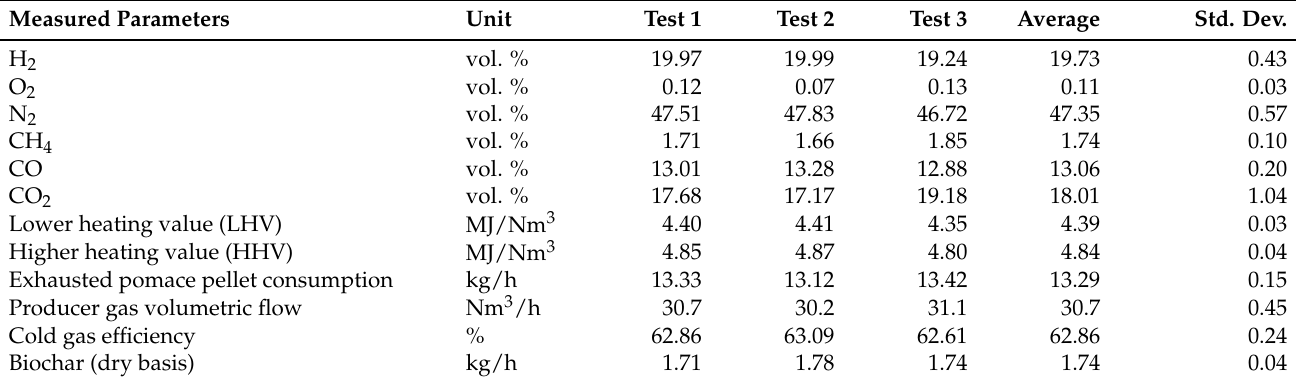
Table 6. Composition of the producer gas and efficiency parameters of the gasification